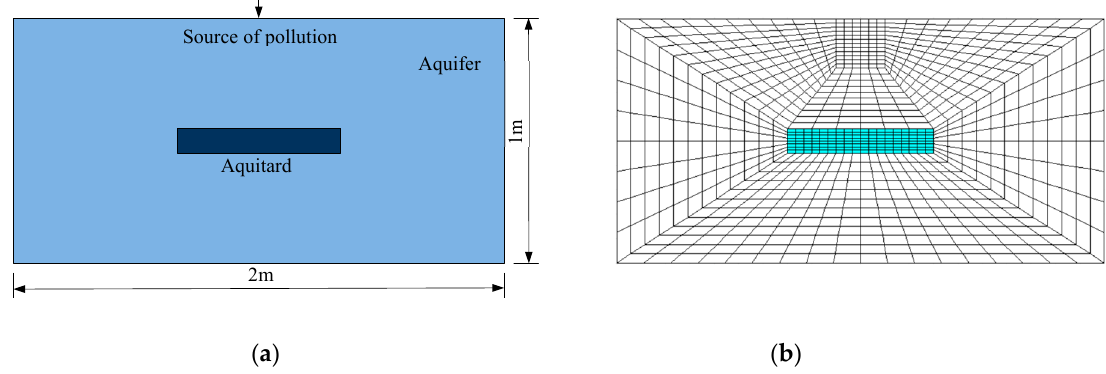
Figure 10. Aqueous model test: ( a ) Model size and boundary conditions; and ( b ) model meshing. For model aquifers and Table 2. Physical properties of media (24 °C).